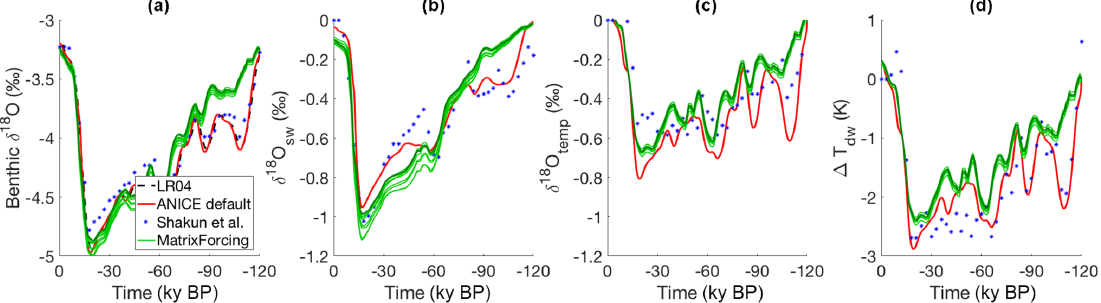
Figure 12. (a) Modelled benthic oxygen isotope abundance from the default ANICE model (de Boer et al., 2014) and the LGM benchmark experiment compared to different datasets (LR04, Shakun et al., 2015). (b) δ 18 O of seawater due to depletion of heavy isotopes. (c) Contri- bution to benthic oxygen isotope abundance due to changes in deep-water temperature. (d) Derived deep-water temperature anomaly.